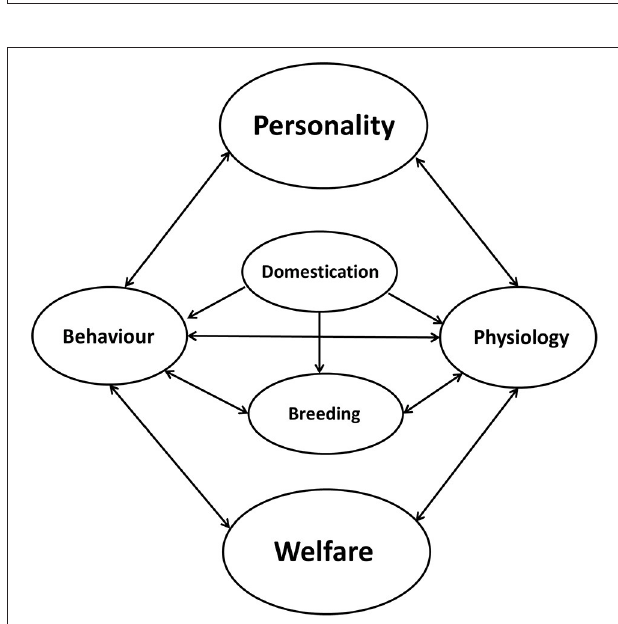
therefore exhibit activation of neuroendocrine systems while a non-fearful animal do not show any enhanced biological responses